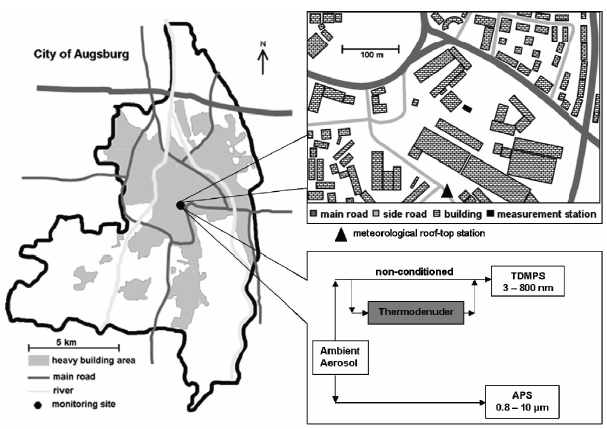
Fig. 1. Regional map of Augsburg, Germany, including the detailed surroundings of the HMGU monitoring station. The lower inset illustrates the concurrent measurement of TDMPS and APS size distributions with the option of using a thermodenuder upstream the